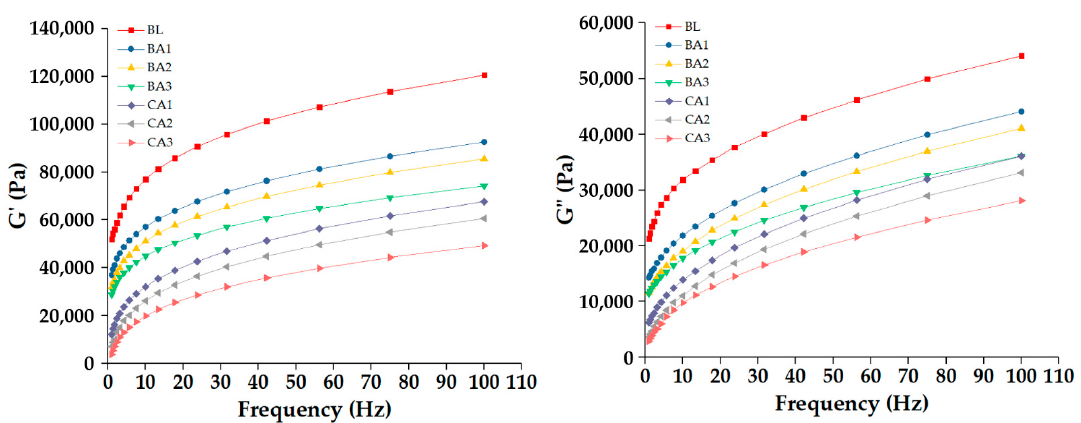
Figure 6. Effect of acidification methods on dough elastic modulus (G’) and viscous modulus (G”): (BL) blank group; (BA1) bio-acidification for 4 h; (BA2) bio-acidification for 12 h; (BA3) bio-acidification for 20 h; (CA1) chemical acidification to BA1 pH level; (CA2) chemical acidification to BA2 pH level; (CA3) chemical acidification to BA3 pH level.